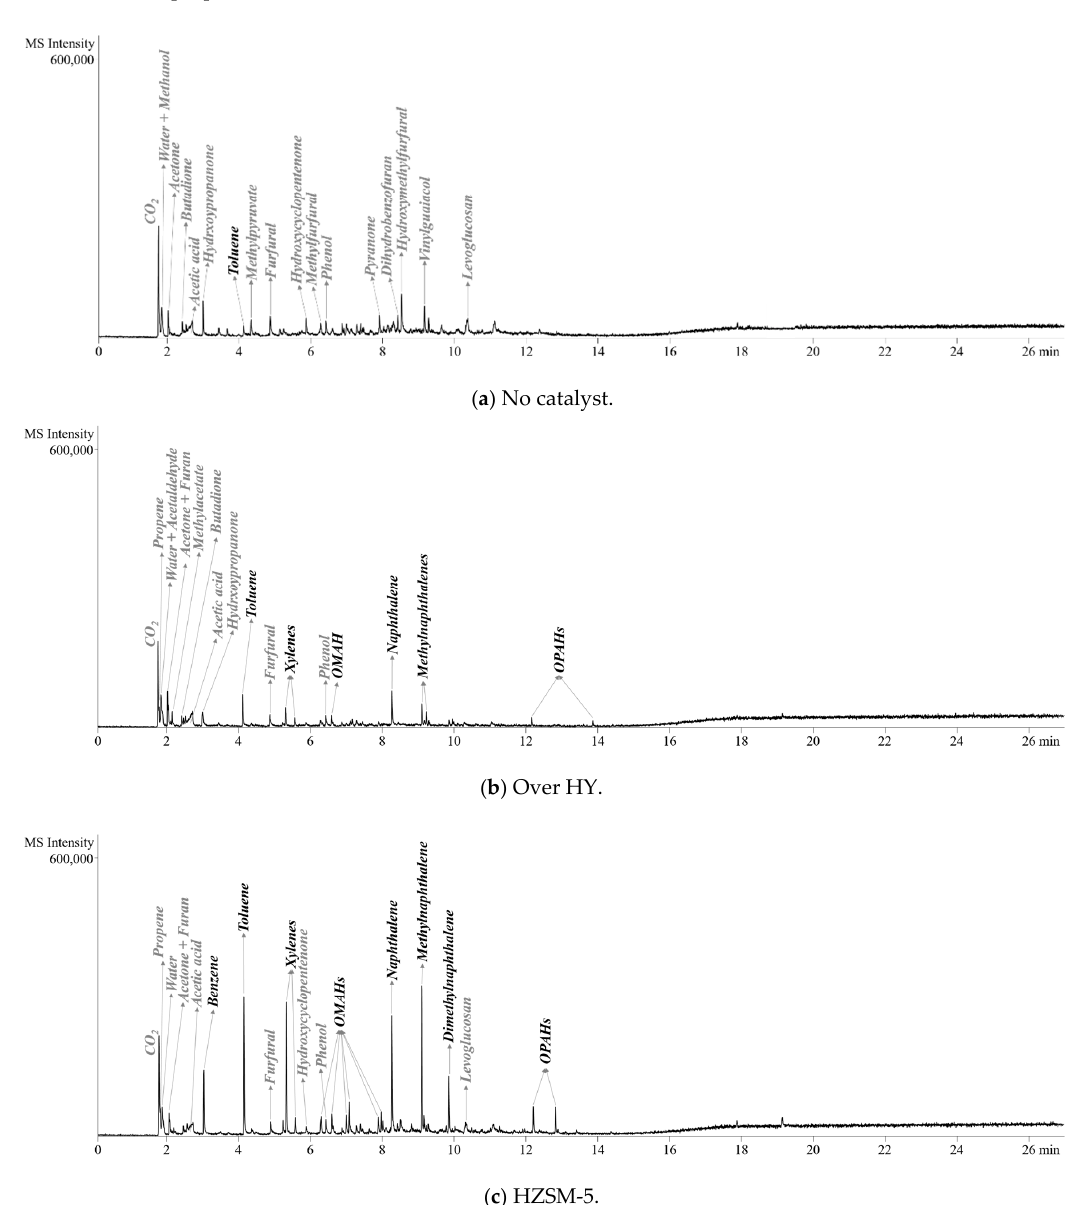
Figure 4. Mass spectrometry (MS) chromatograms obtained from the non-catalytic fast pyrolysis (NCFP) and CFP of MP over HY and HZSM-5 at 600 °C. (OMAHs: other mono aromatic hydrocarbons, OPAHs: Other poly aromatic hydrocarbons).